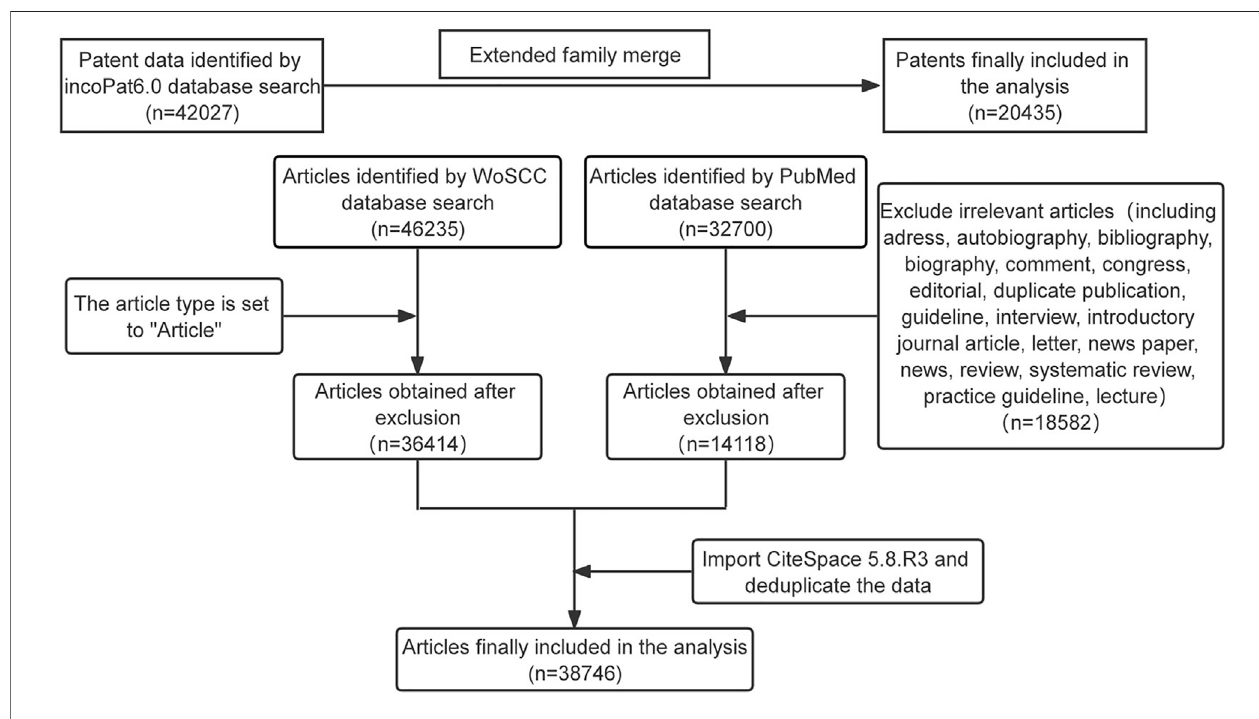
FIGURE 1 | Flow chart of data collection.